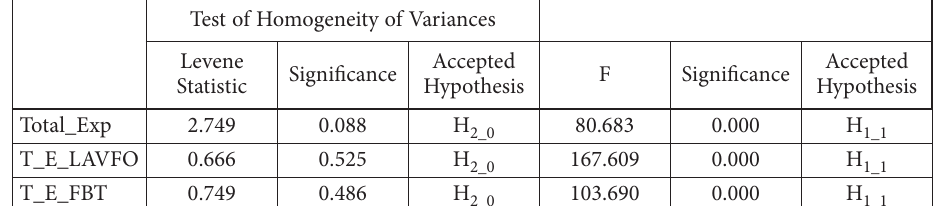
Table 8. The results of testing the statistical significance of Romania’s export volumes average values in the year 2016, at EU states group level (source: authors’ own computations) Test of Homogeneity of Variances Levene Accepted Significance F Significance Statistic Hypothesis